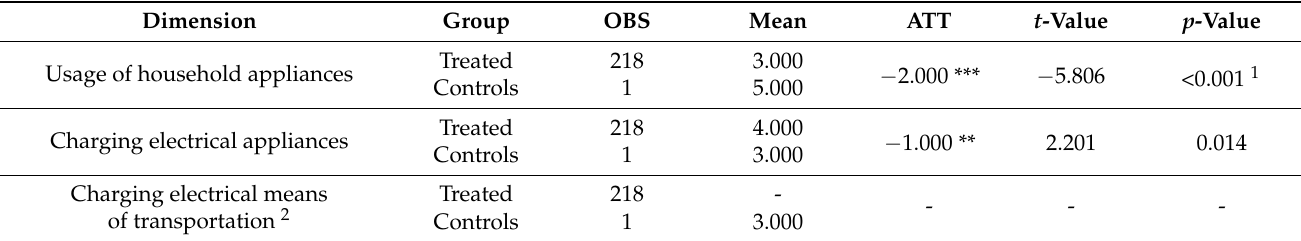
Table 5. Demand flexibility comparisons of Solar-owners (treated) versus Biogas-owners (controls) (source: authors’ own